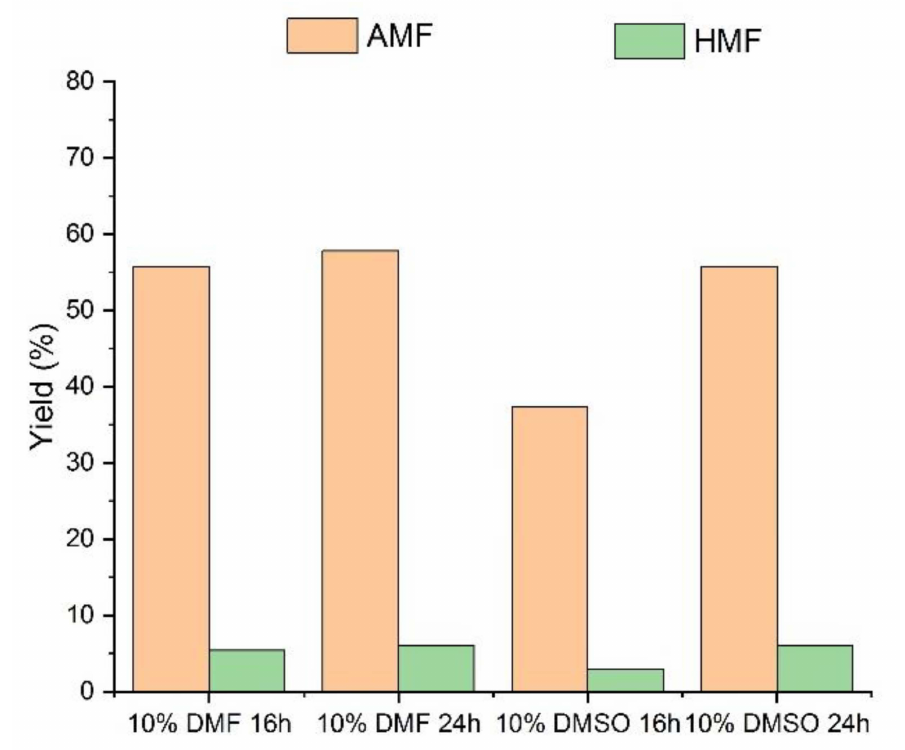
Figure 7. The yield of AMF and HMF after dehydration of the MAG and DAF mixture in a dual- solvent